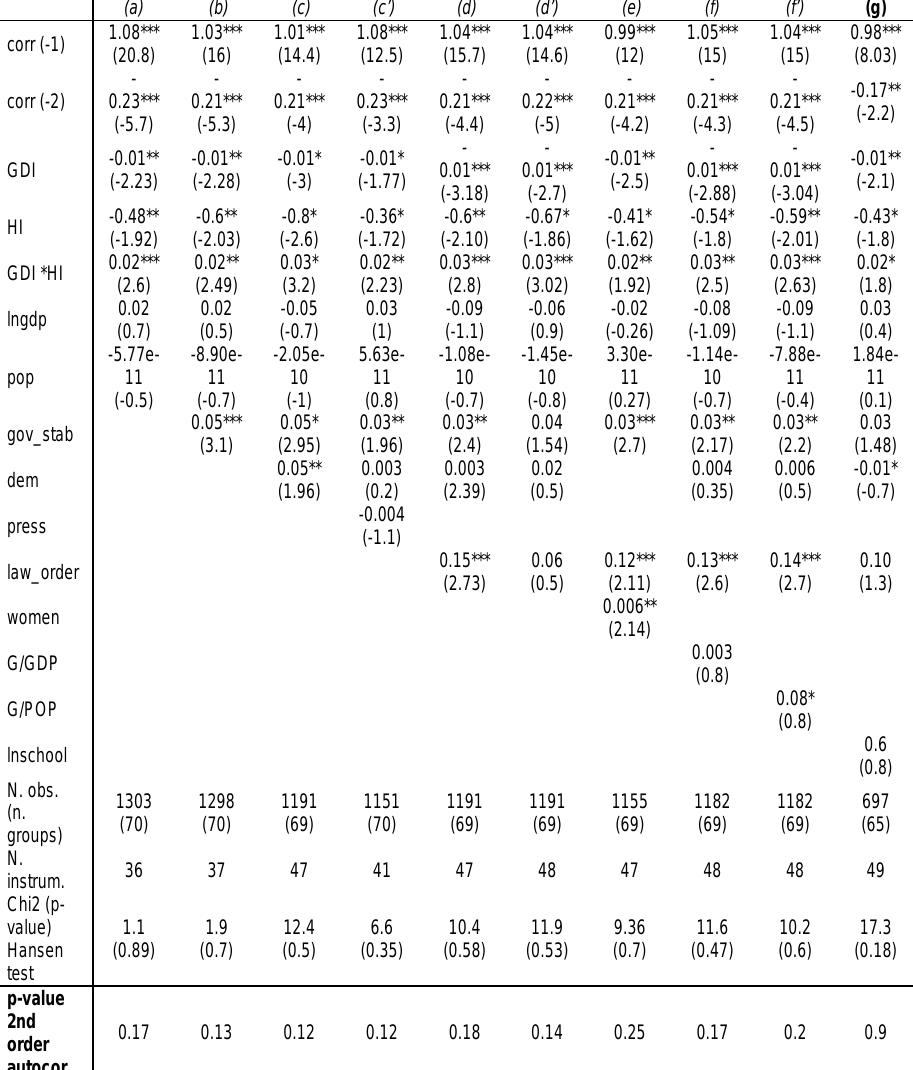
Table 2. Estimation results. Dependent variable: Corruption